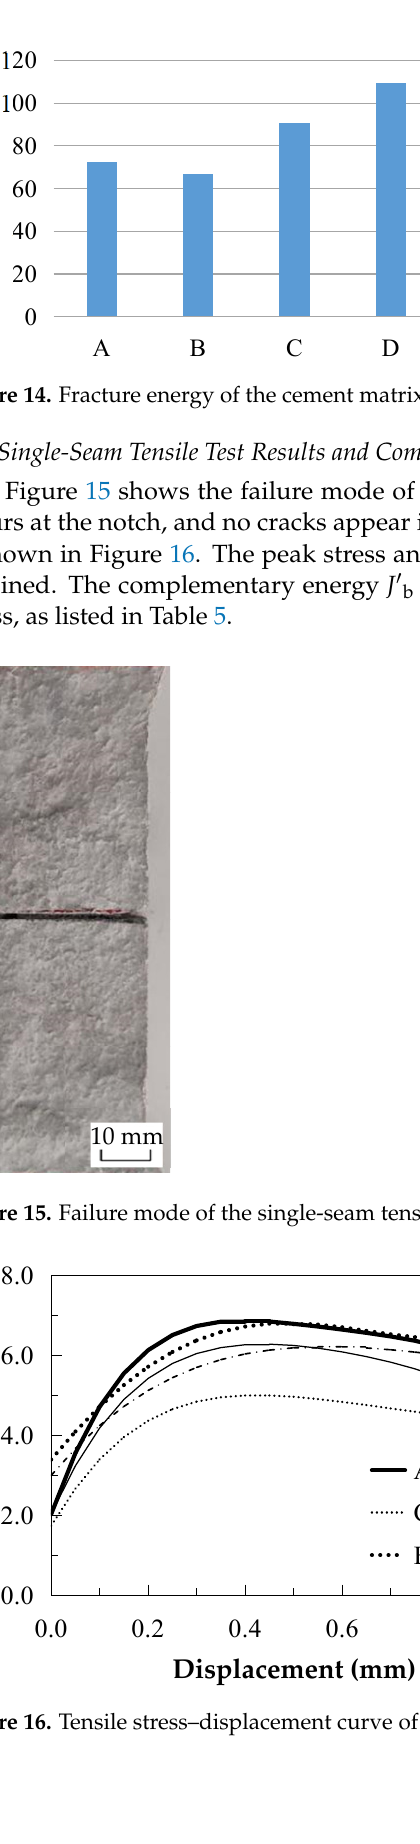
Figure 13. Failure mode of the three-point bending test specimen.